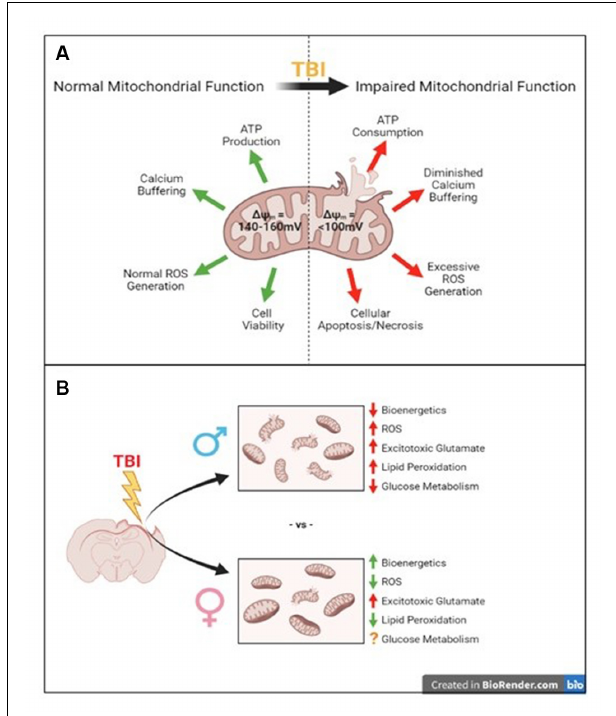
FIGURE 1 | Summary of traumatic brain injury-induced mitochondrial disruptions compared to their normal functions and what we know so far about sex-specific differences in these disruptions. (A) Normal mitochondrial function is disrupted after traumatic brain injury (TBI). (B) The well-known consequences of TBI such as impaired mitochondrial bioenergetics, increased reactive oxygen species (ROS), increased excitotoxicity and lipid peroxidation, and impaired glucose metabolism have been established in male models of injury. The few studies addressing these in female models have shown increased bioenergetics, reduced ROS, increased acute glutamate levels, and reduced lipid peroxidation, though glucose metabolism is still unclear compared to